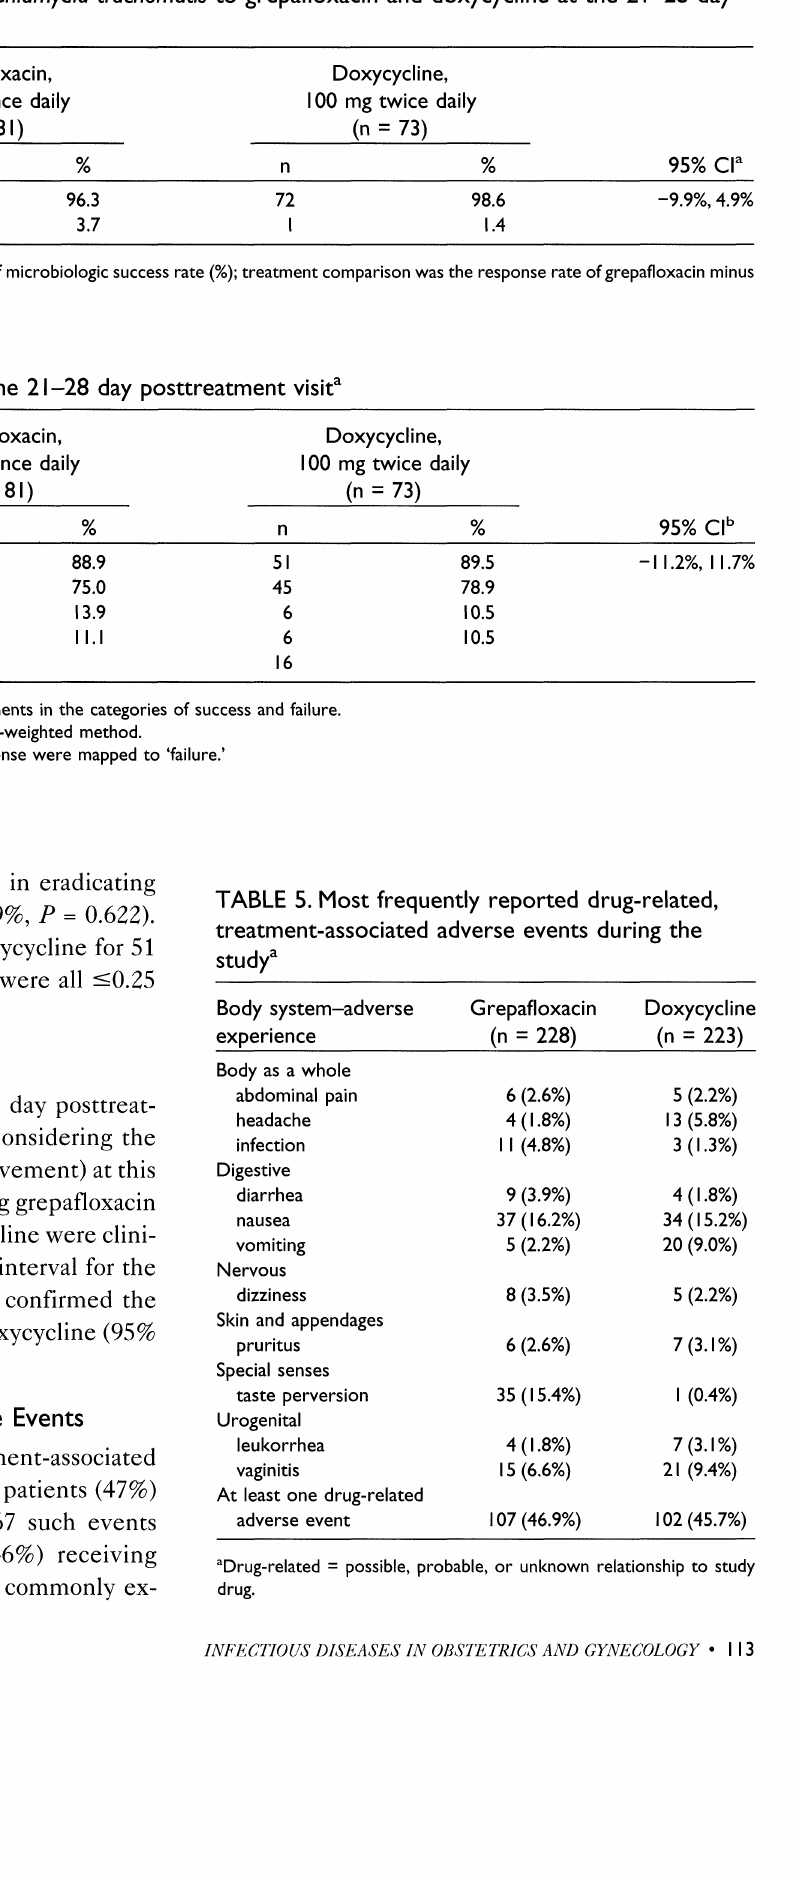
TABLE 3. Microbiologic response of Chlamydia trachomatis to grepafloxacin and doxycycline at the 21-28 day posttreatment visit